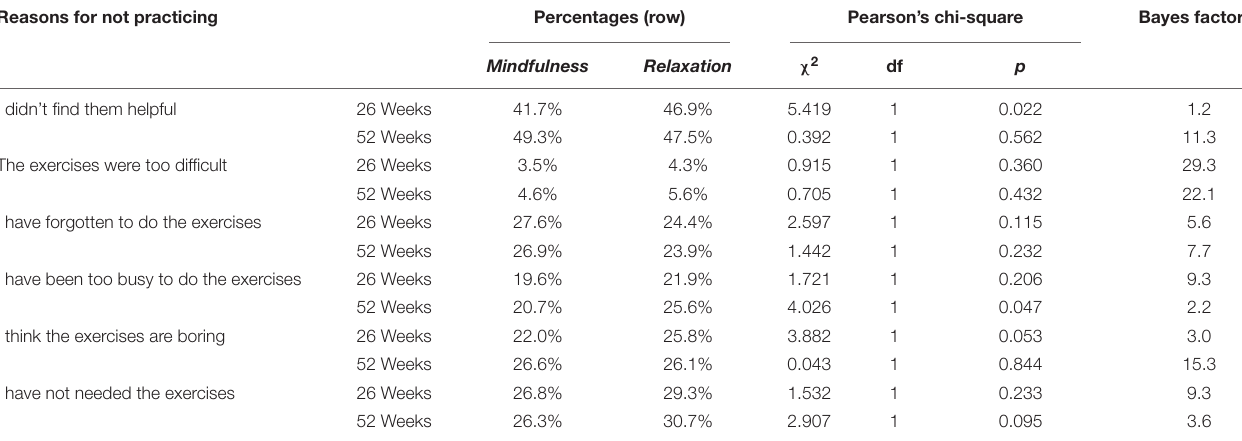
TABLE 2 | Differences in reasons for not